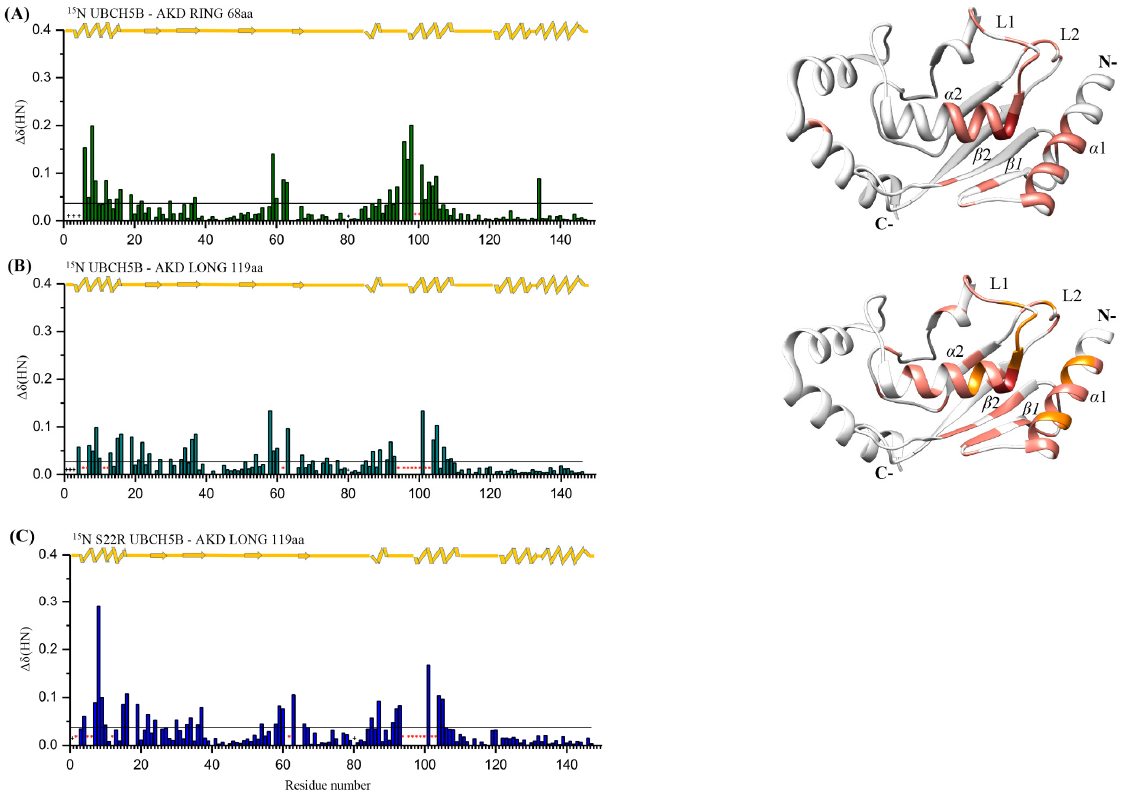
Figure 6. Bar graphs of UBCH5B’s CSPs and UBCH5B mapping (PDB code: 2ESK) after addition of: ( A ) Ark 68 aa and ( B ) Ark 119 aa. The residues that disappeared during the interaction are colored red, while the residues that exhibited fast exchange interaction are colored coral. Residues that change from fast to intermediate exchange due to the stronger binding with Ark 119 aa are colored orange. ( C ) Bar graphs of S22R UBCH5B’s CSPs after addition of Arkadia 119 aa. *: Represents disappeared residues, +: represents residues with no information.